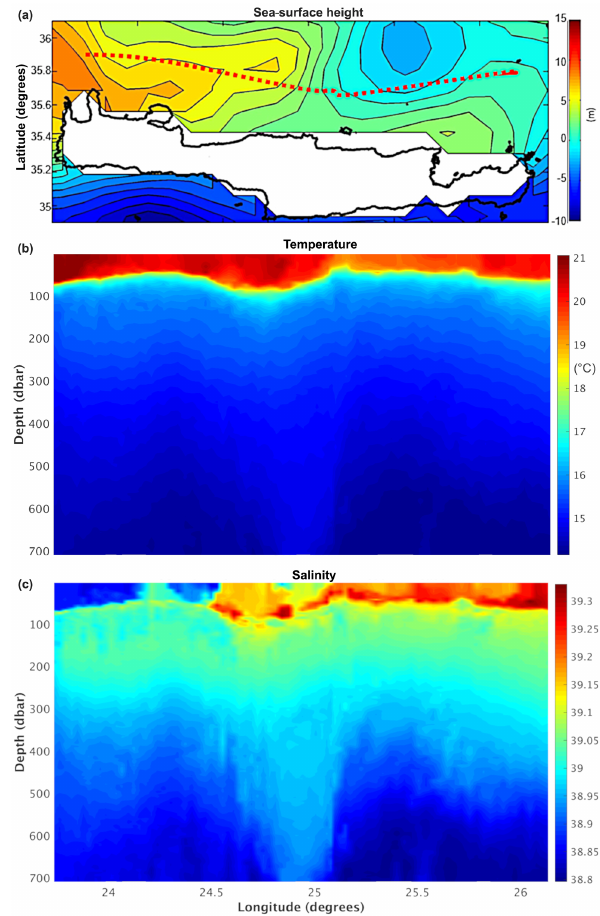
Figure 9. Sea-surface height (a) derived from satellite altimetry in the Cretan Sea in November 2017, in comparison to the vertical distribution of temperature (b) and salinity (c) obtained by the glider along a west–east transect (red dotted line in panel a